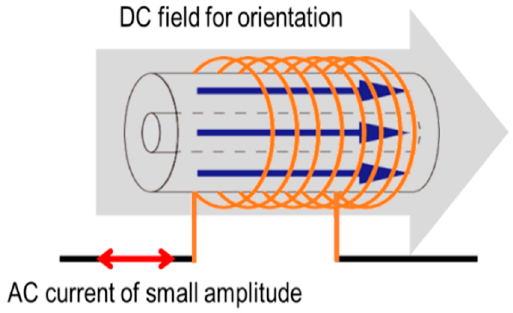
Figure 6. Excitation of the wire by AC current under DC bias field to orient the magnetization.